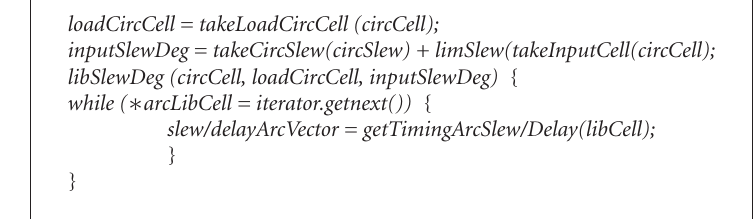
Algorithm 4: Pseudocode of libSlewDeg calculation.